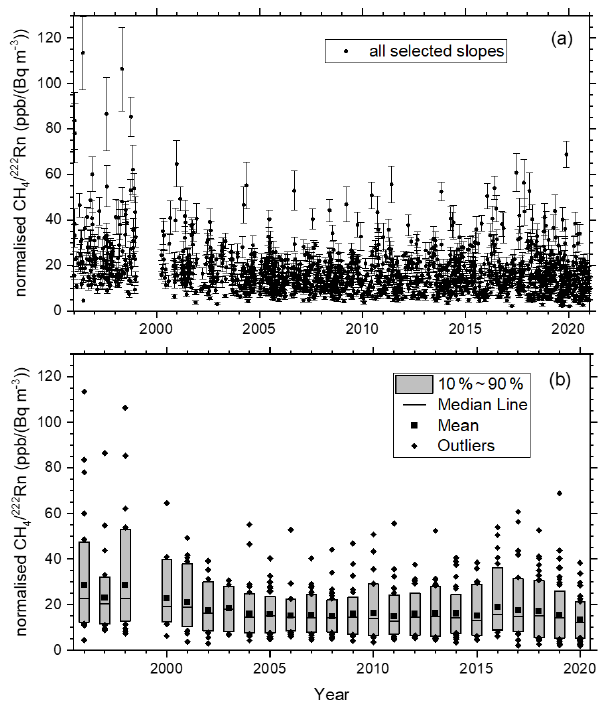
Figure 5. (a) Individual normalised CH 4 / 222 Rn slopes and their 1 σ uncertainties of linear regressions with R 2 ≥ 0 . 7, calculated from half-hourly nighttime (21:00 to 04:00CET) data. (b) Annually ag- gregated CH 4 / 222 Rn slopes presented as box plots with the boxes including 80% of the